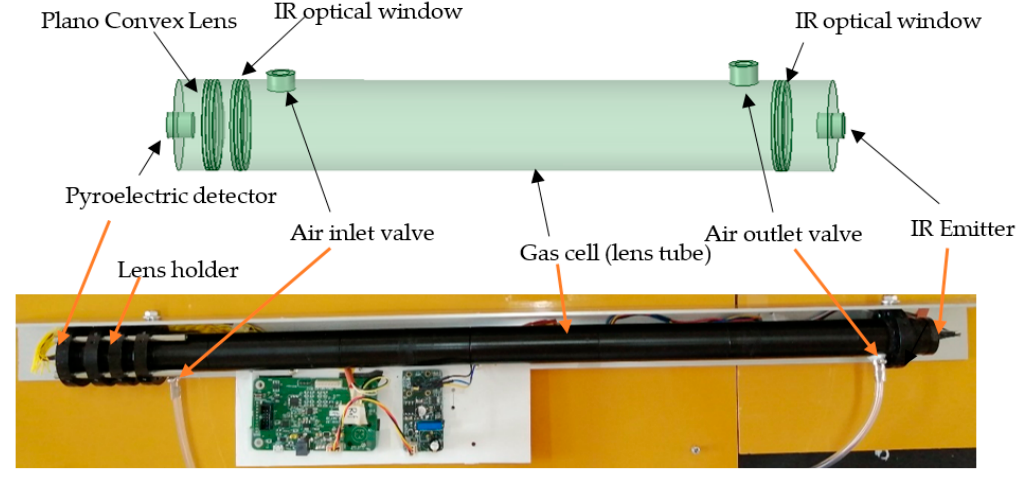
Figure 1. Schematic diagram of the developed gas cell with optical components and the assembled gas monitoring device.